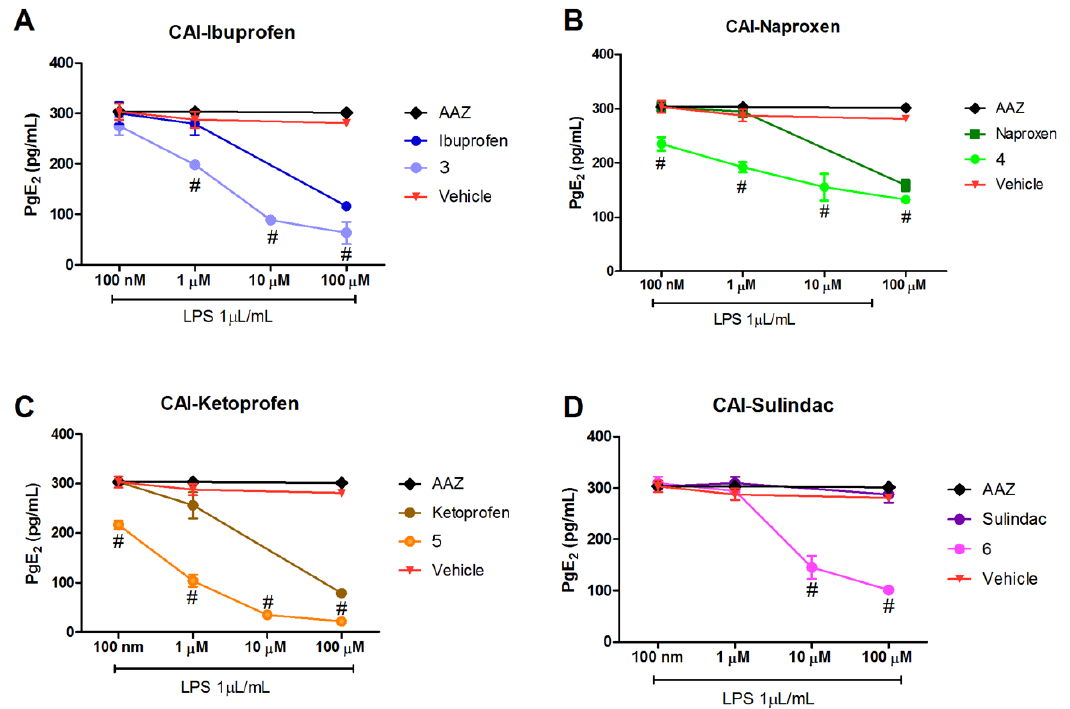
Figure 2. E ff ects of di ff erent concentrations of ( A ) CAI-ibuprofen, ( B ) CAI-naproxen, ( C ) CAI-ketoprofen and ( D ) CAI-sulindac on lipopolysaccharide (LPS)-induced prostaglandin E 2 (PGE 2 ) production in RAW 264.7 cells. The cells were pretreated with the studied compounds (100 nM, 1 µ M, 10 µ M and 100 µ M) for 1 h, followed by LPS (1 µ g / mL) stimulation for 18 h. PGE 2 production analysis was carried out by using cell culture supernatants. PGE 2 production of Control (naïve cells not treated with LPS) is 36.279 ± 0.67 pg / mL. Values represent the mean ± SEM of eight independent experiments ( # p < 0.05 between a Nonsteroidal Anti-Inflammatory Drug (NSAID) and a Carbonic Anhydrase Inhibitor connected to a Nonsteroidal Anti-Inflammatory Drug (CAI-NSAID)).